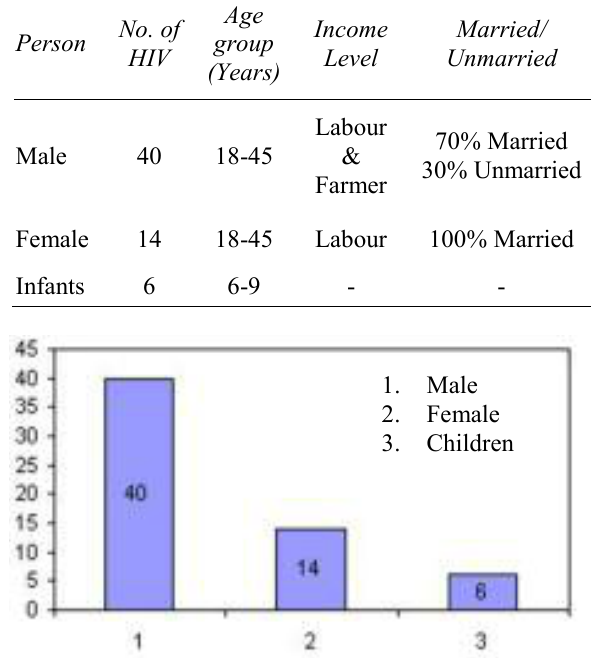
Figure 4: HIV Infected male, female and children